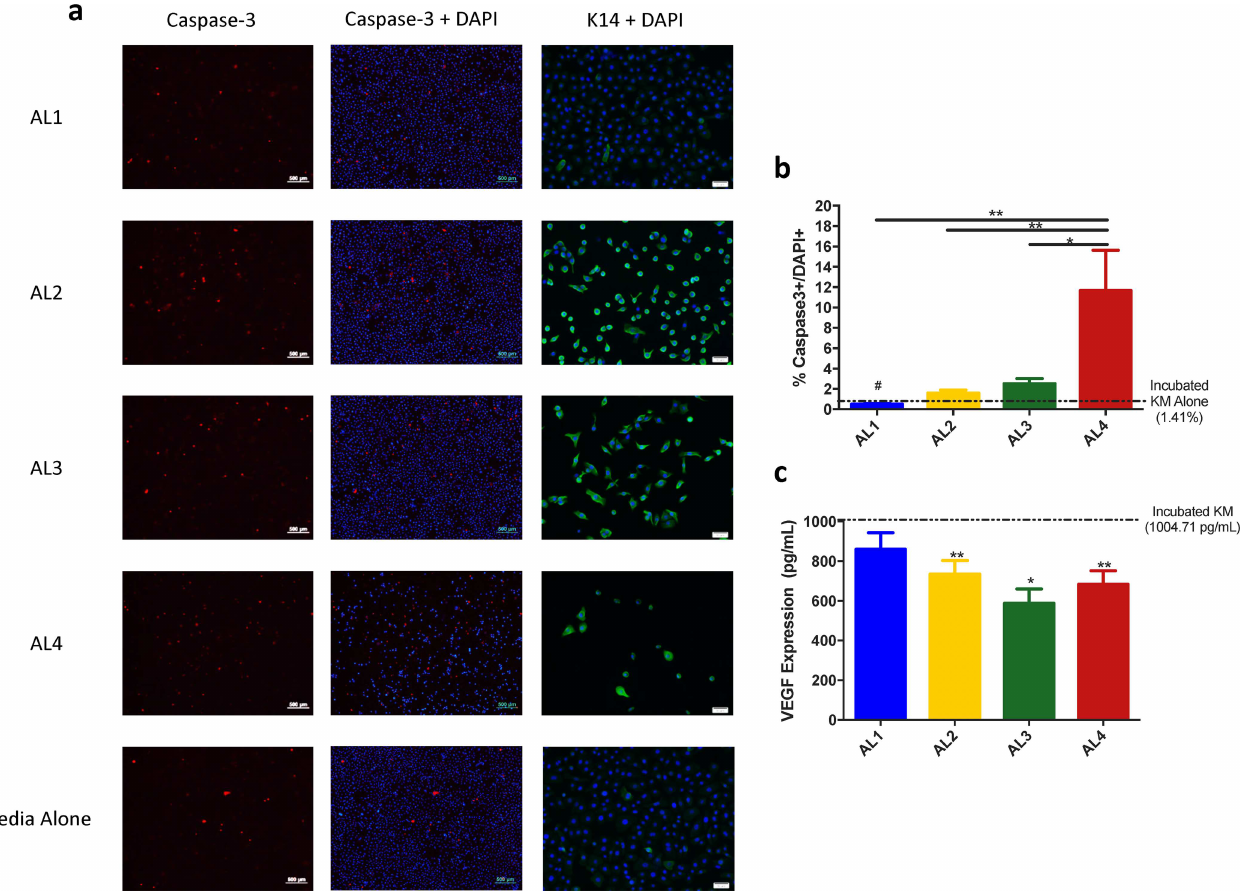
Fig 6. The effect of KM-BTM on Keratinocyte viability, differentiation, and VEGF release. (a and b) NHEKs were treated with KM-BTM, fixed, and stained with caspase-3. The percentage of cells expressingcaspase-3 is higher in NHEKs treated with BTM from AL4 compared to other locations (p < 0.02) and lower in AL1 (p = 0.0003) compared to incubatedKM. (a, right column) Cytokeratin-14 expression was maintained when incubatedin BTM from AL2-4 but not in AL1 or KM alone. For caspase-3 stain, 4x images are shown and scale bars represent 500 μ m. For K-14 stain, 10x images are shown and scale bar represents 50 μ m. (c) VEGF protein levels in cell supernatantwere decreased following incubationin BTM from all locations(p < 0.01) except for AL1 compared to incubatedkeratinocyte media (two tailed unpairedt-test, n = 7/AL).